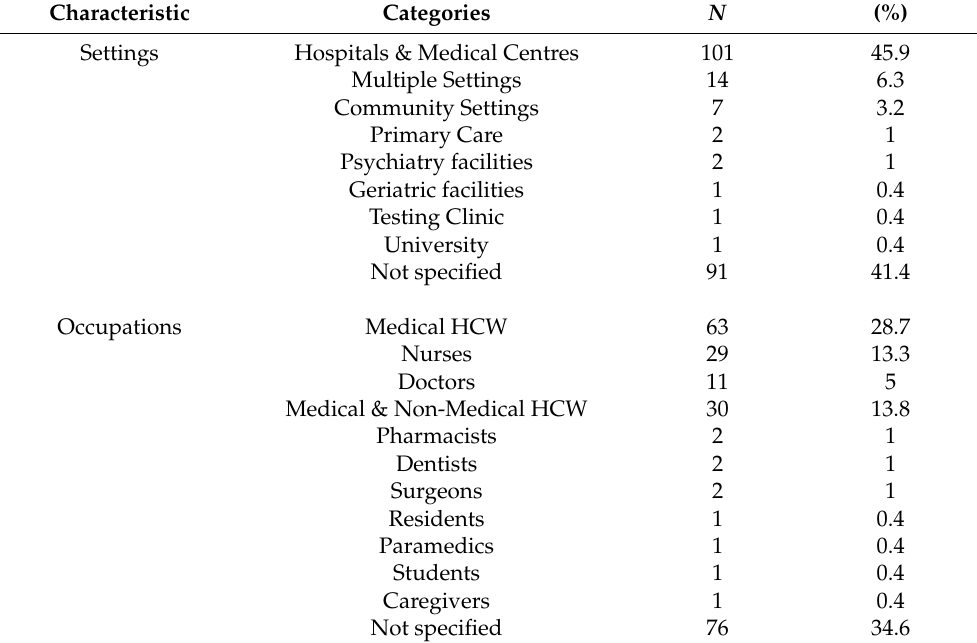
Table 1. Settings and occupations